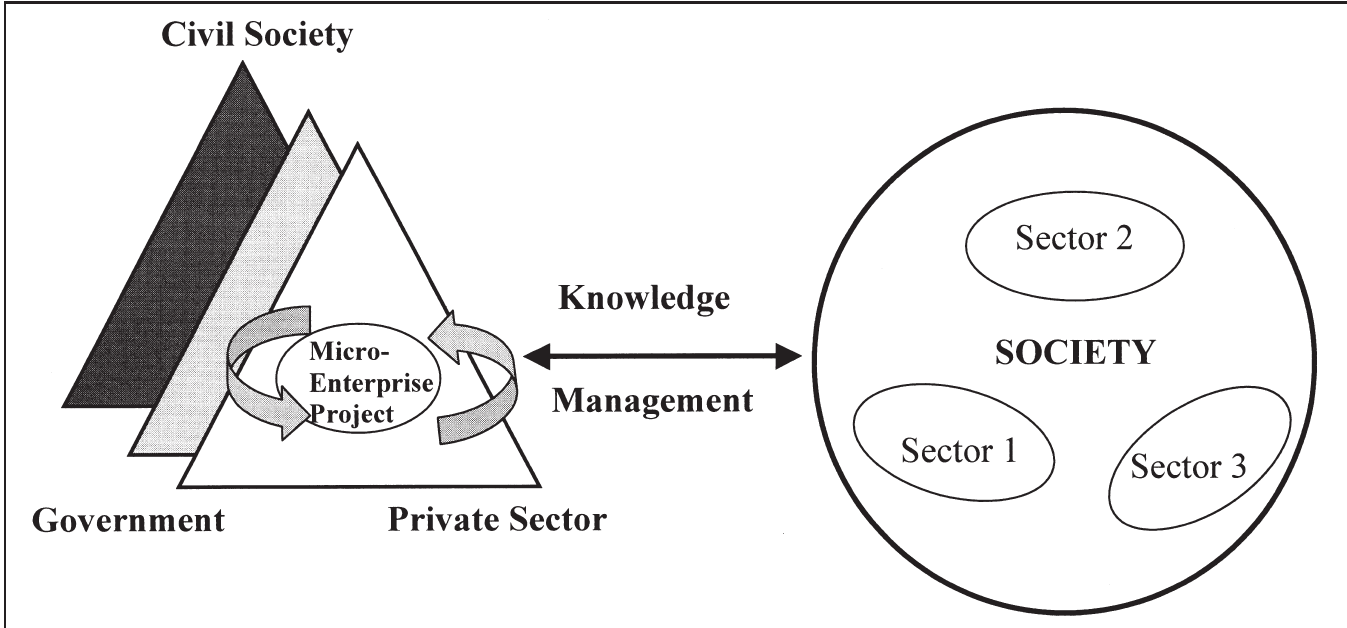
Figure 3. Sector-Based Knowledge